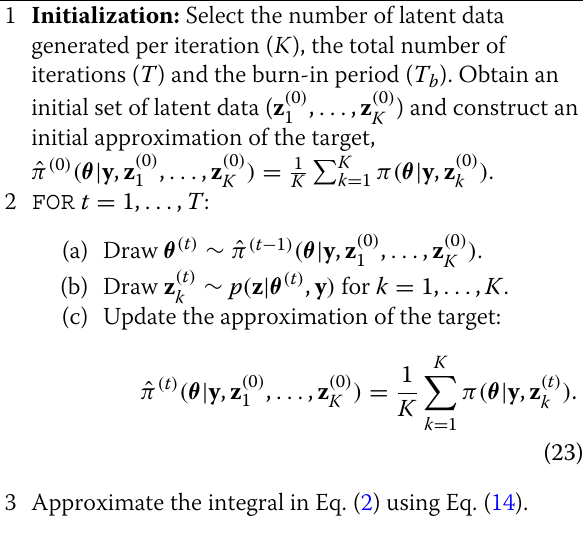
Algorithm 8 Basic Data Augmentation (DA)